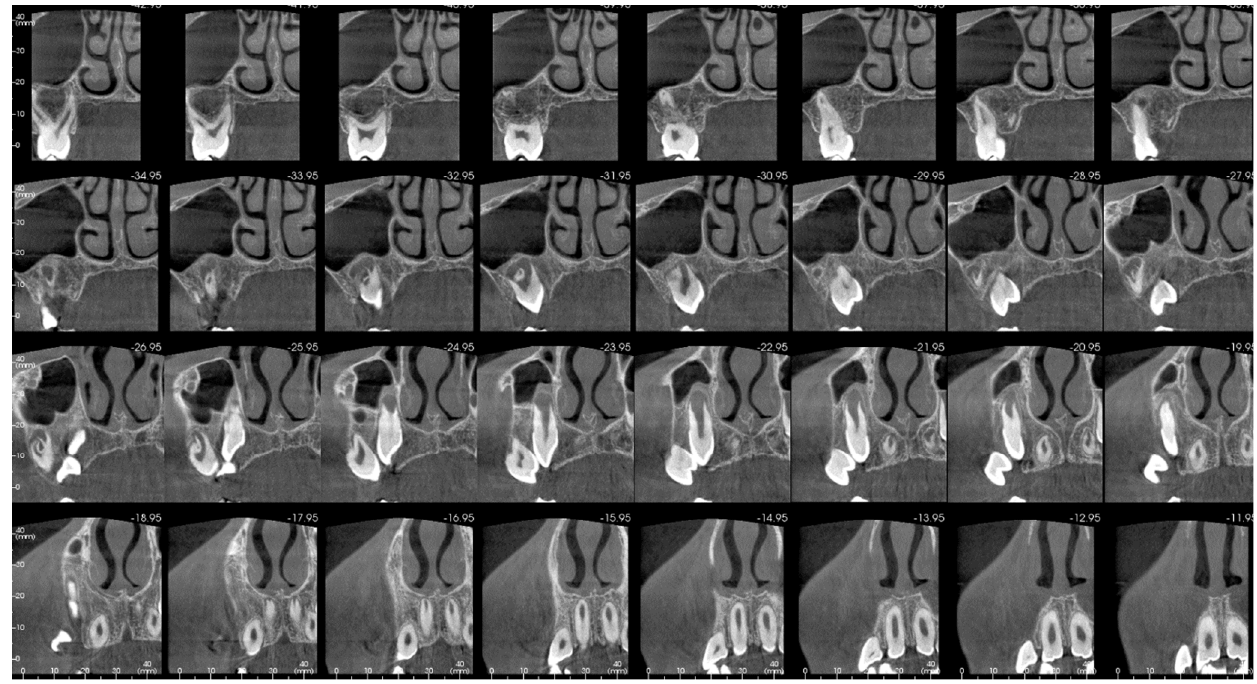
Figure 10. CBCT 6 months after surgery—coronal view.